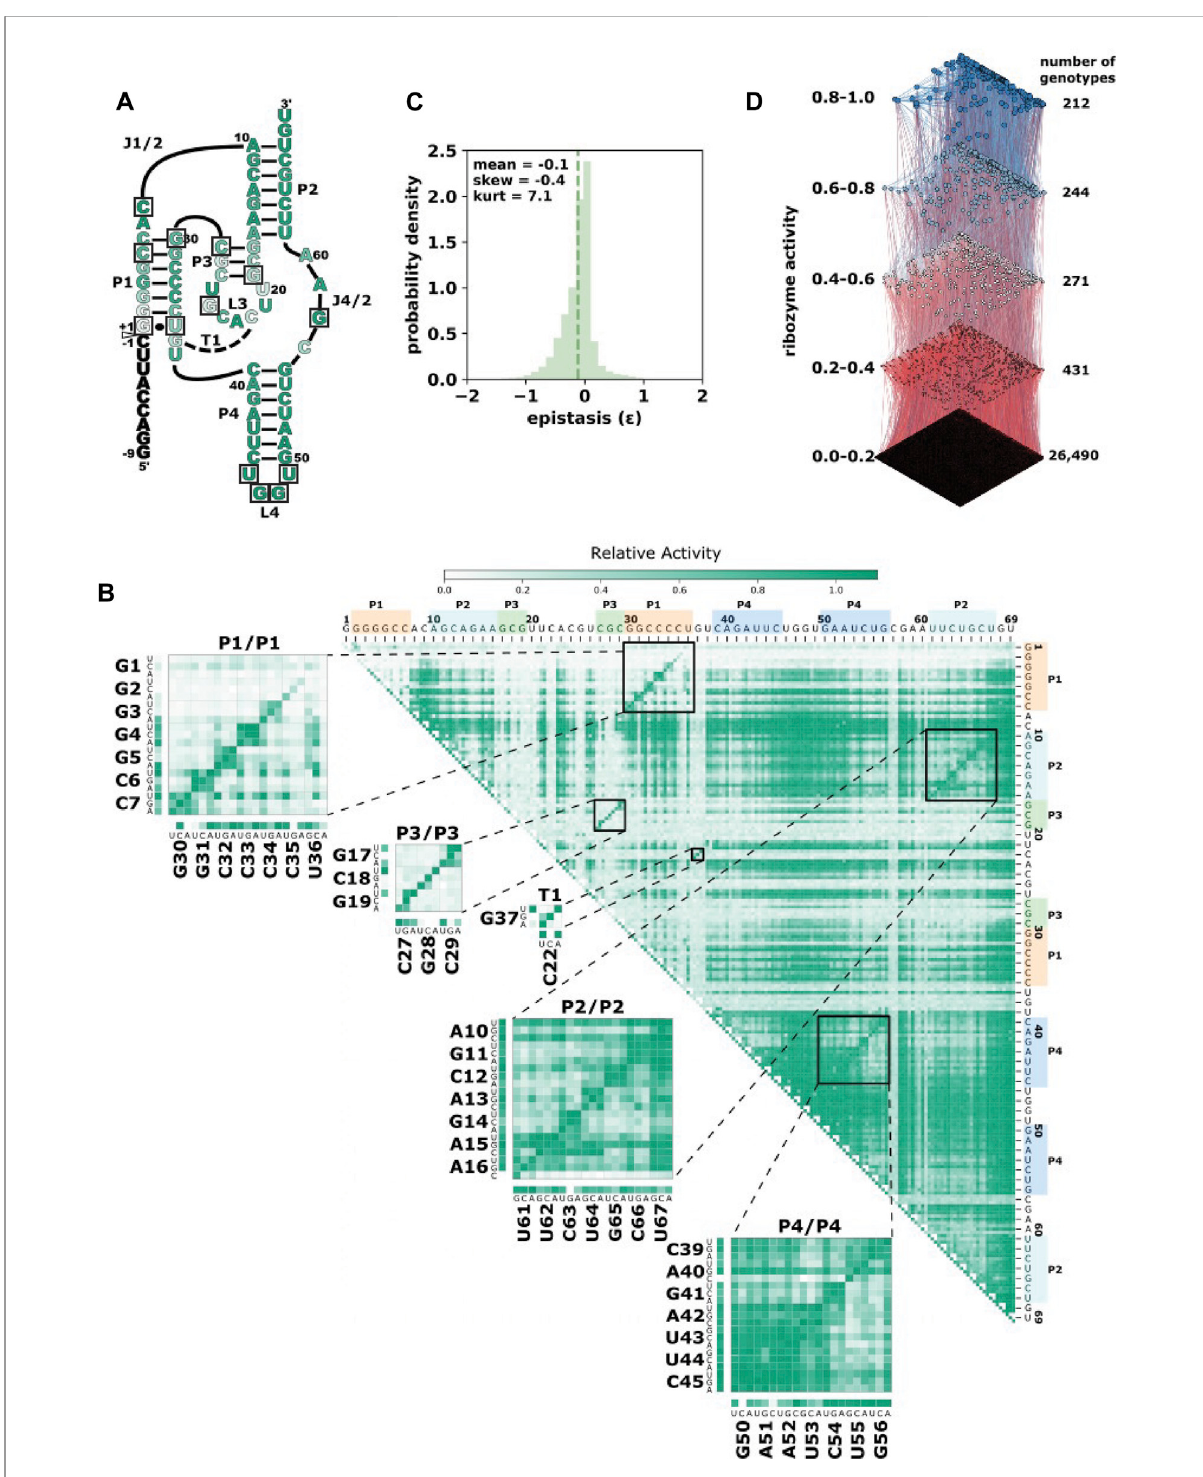
FIGURE 1 TheCPEB3ribozymeanddatapredictionchallenge. (A) SecondarystructurediagramoftheCPEB3ribozyme.Thewhitearrowindicatesthesite of self-cleavage. Nucleotide color indicates the average relative activity of the three possible point mutations at each position. Boxes indicate nucleotide positions mutated in the phylogenetically derived higher-order mutants (B) Heatmap representation of comprehensive single and double-mutant data. Each pixel in the heatmap shows the ribozyme activity for a speci fi c double mutant indicated by the nucleotide positions on the top and right of the heatmap. Insets show base paired regions and speci fi c mutations. Ribozyme activity is determined as the fraction of total